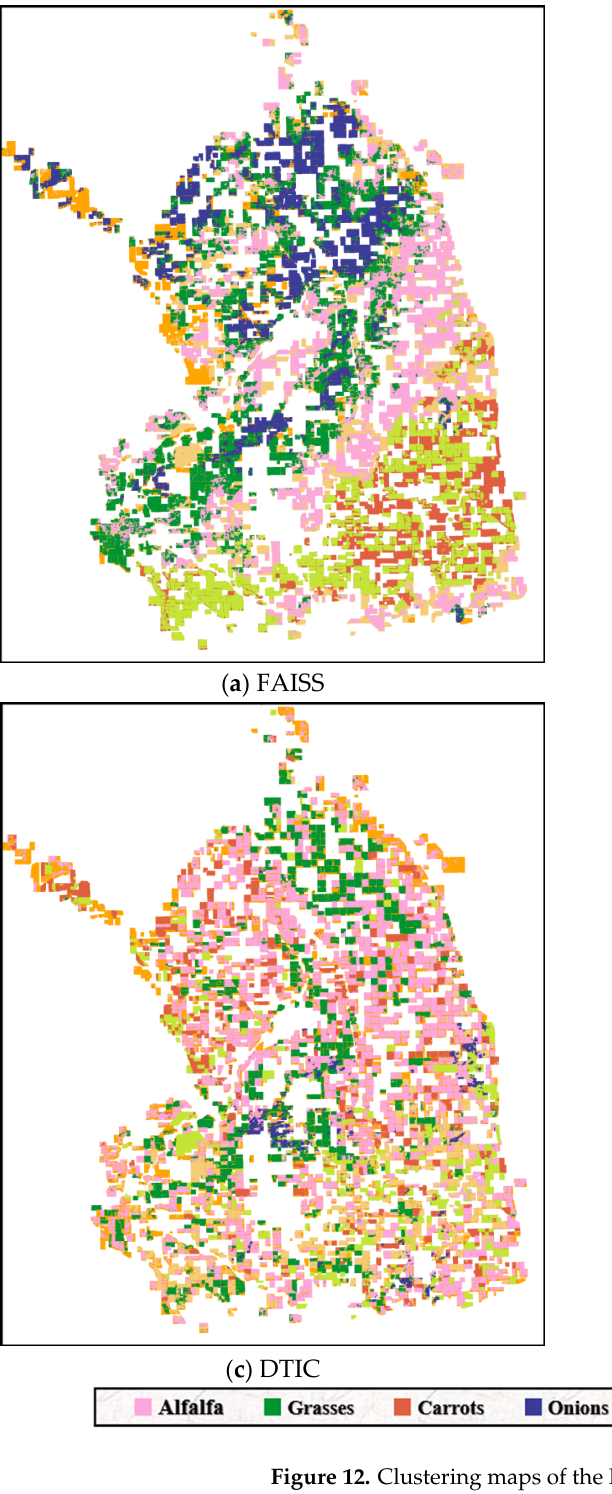
Figure 12. Clustering maps of the Imperial Dataset produced using different methods with random initial cluster centers. ( a ) FAISS; ( b ) K-means; ( c ) DTIC; ( d ) reference